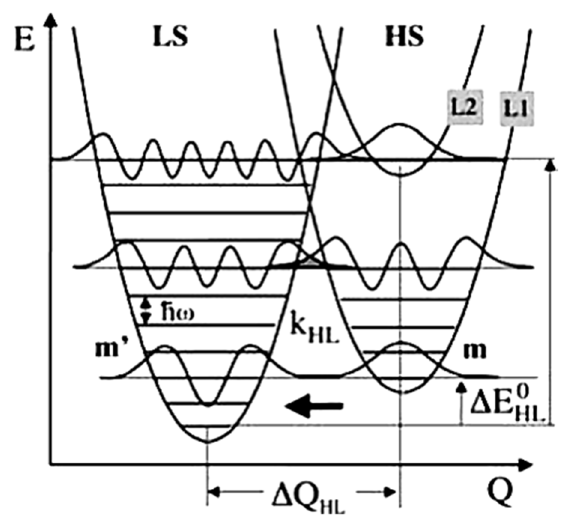
Figure 12. The high spin and low spin state potential wells with respect to the reaction coordinate. At low temperatures effective quantum tunneling occurs from the lowest vibrational level of the high spin state to the vibrational levels in the low spin state. Reprinted with permission from Ref. [72]. Copyright 1969 Springer